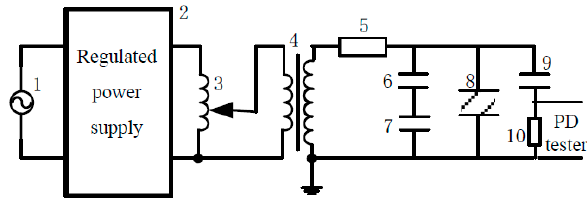
Figure 2. The electrical aging test circuit.